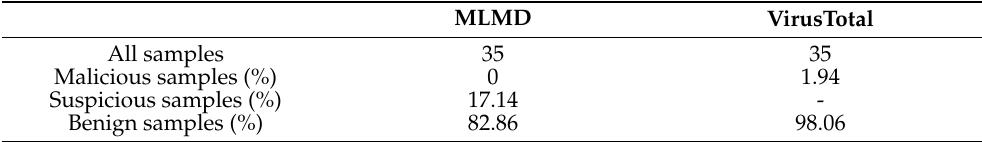
Table 18. Comparison of classifications of benign samples.